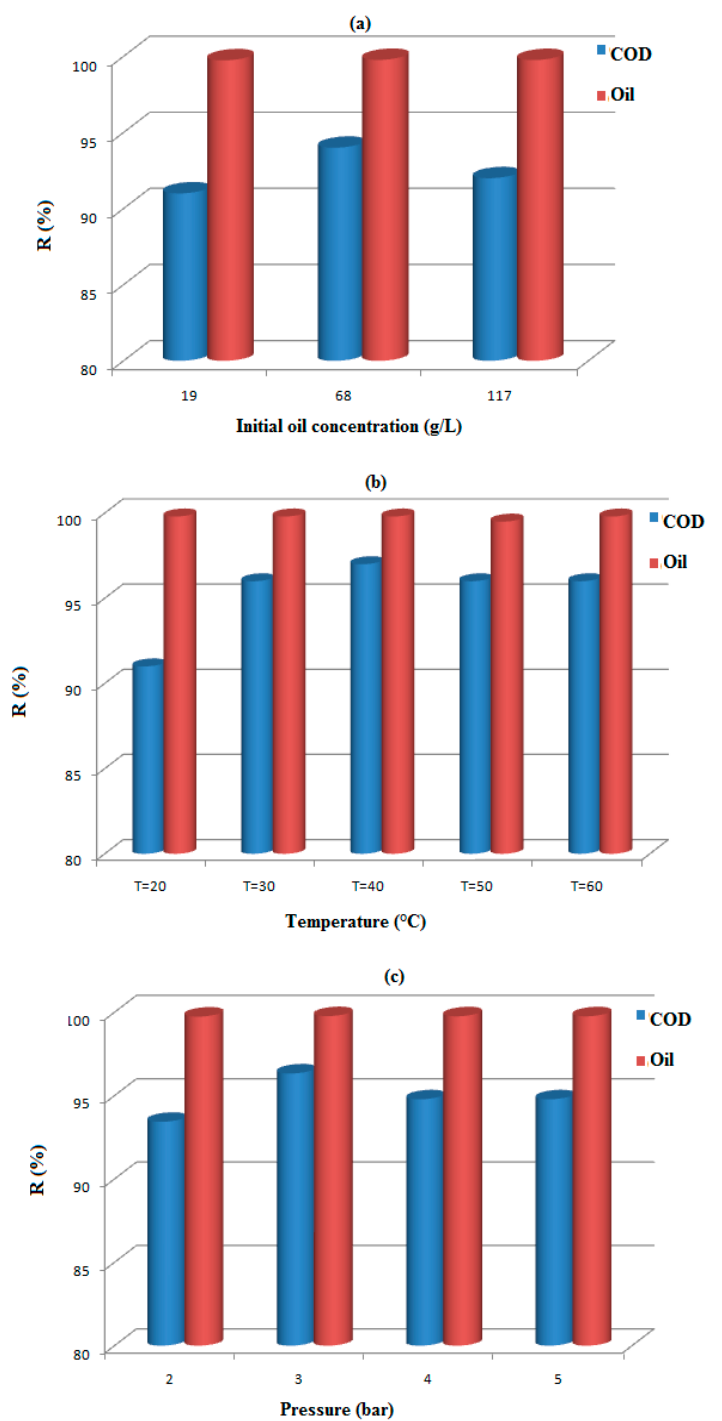
Figure 3. Retention of Oil and COD versus: Initial oil concentration ( a ), Temperature ( b ), Pressure ( c ).